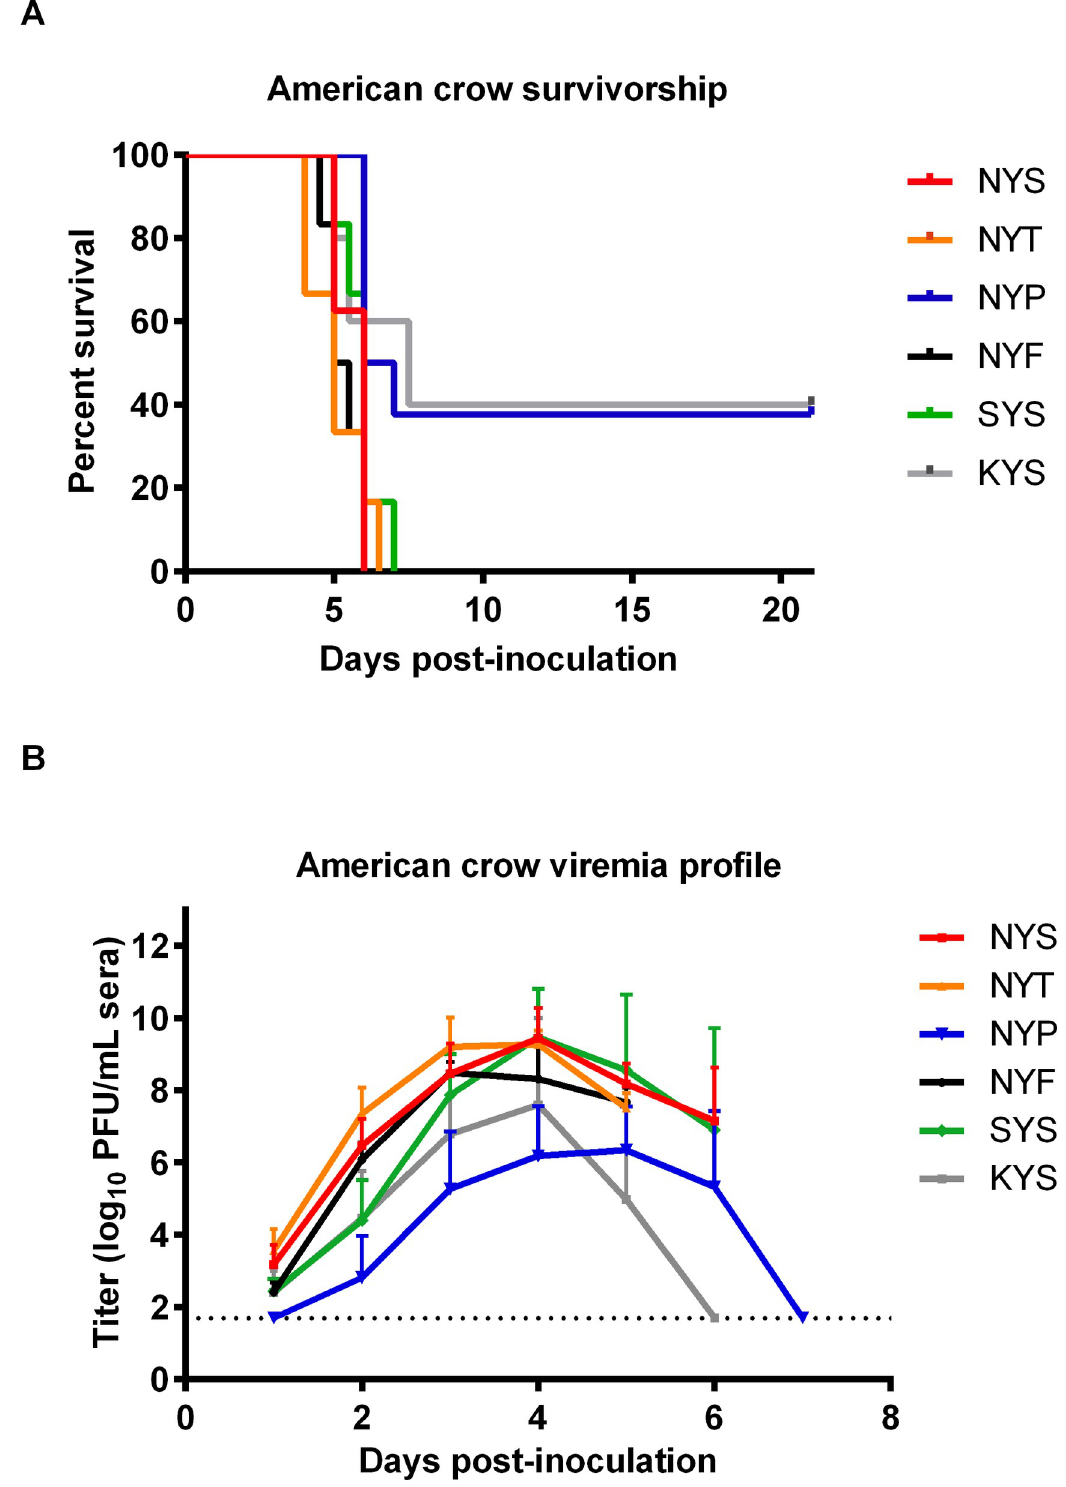
Fig 3. WNV glycosylation mutant virus growth and survivorship in American crows (AMCR). Seven AMCRs were inoculated with 1,500 PFU of parental WNV and mutants. Graphs represent (A) survivorship and (B) mean daily peak viremias (error bars denoted standard deviations from the mean) in log 10 PFU/mL sera. LODs are shown by dashed line.